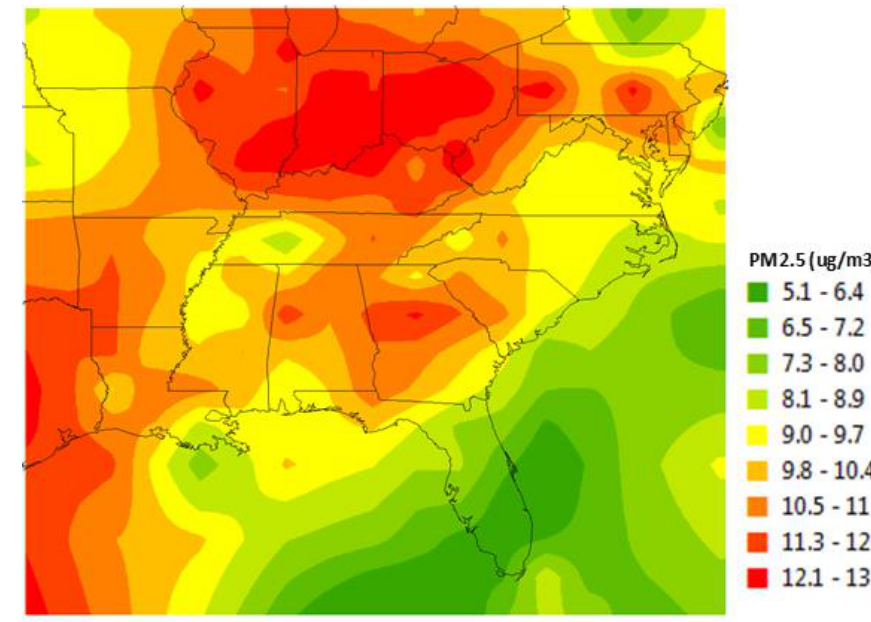
Figure 1. Mean annual 3-km fine particulate matter (PM 2.5 ) for 2009.